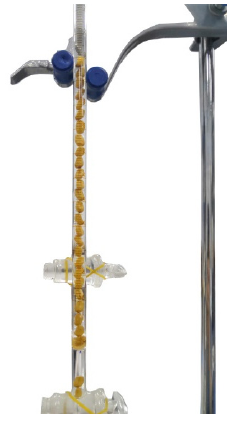
Figure 9. Manual measurement of grain volume.